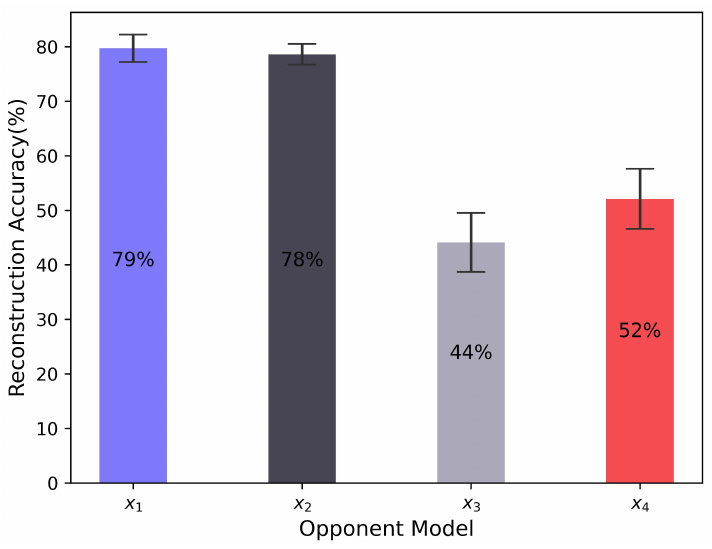
Figure 4. The accuracy of the opponent model in reconstructing the opponent’s